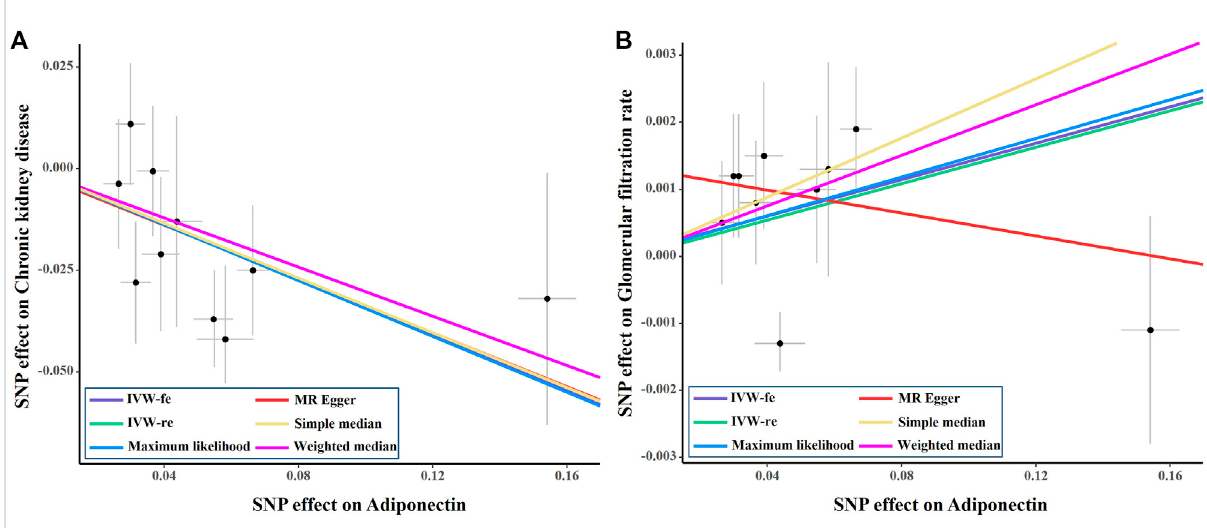
FIGURE 2 Scatter plot of the effect size of each SNP on adiponectin, eGFR and CKD in SVMR. SNP, single nucleotide polymorphism; eGFR, estimated glomerular fi ltration rate; IVW, Inverse variance weighted method; CKD, chronic kidney disease; MR, Mendelian randomization.